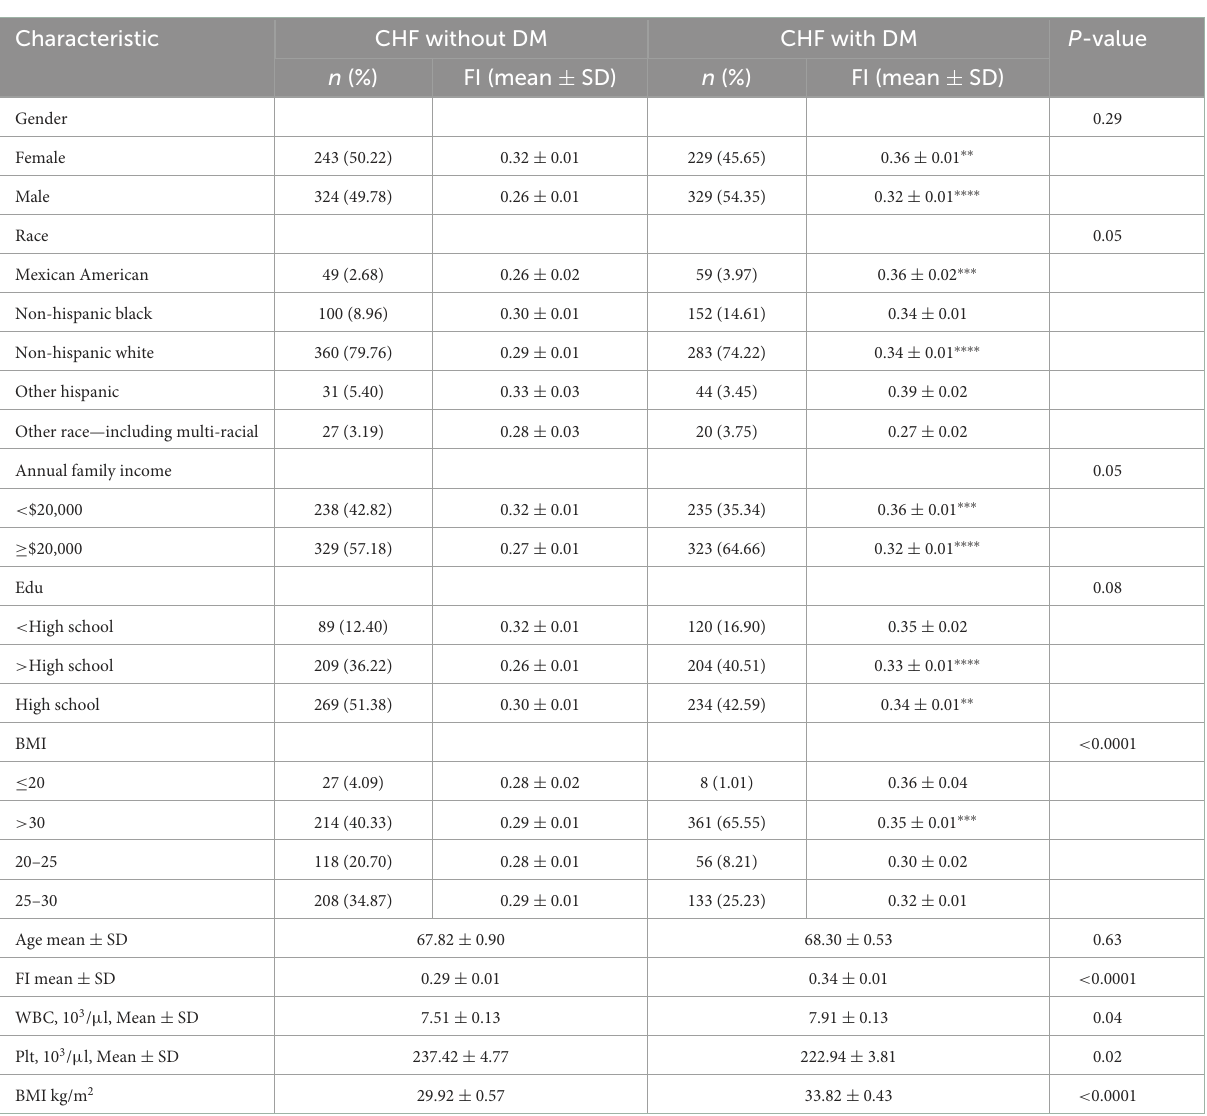
TABLE 5 Subgroup analysis for CHF with DM.